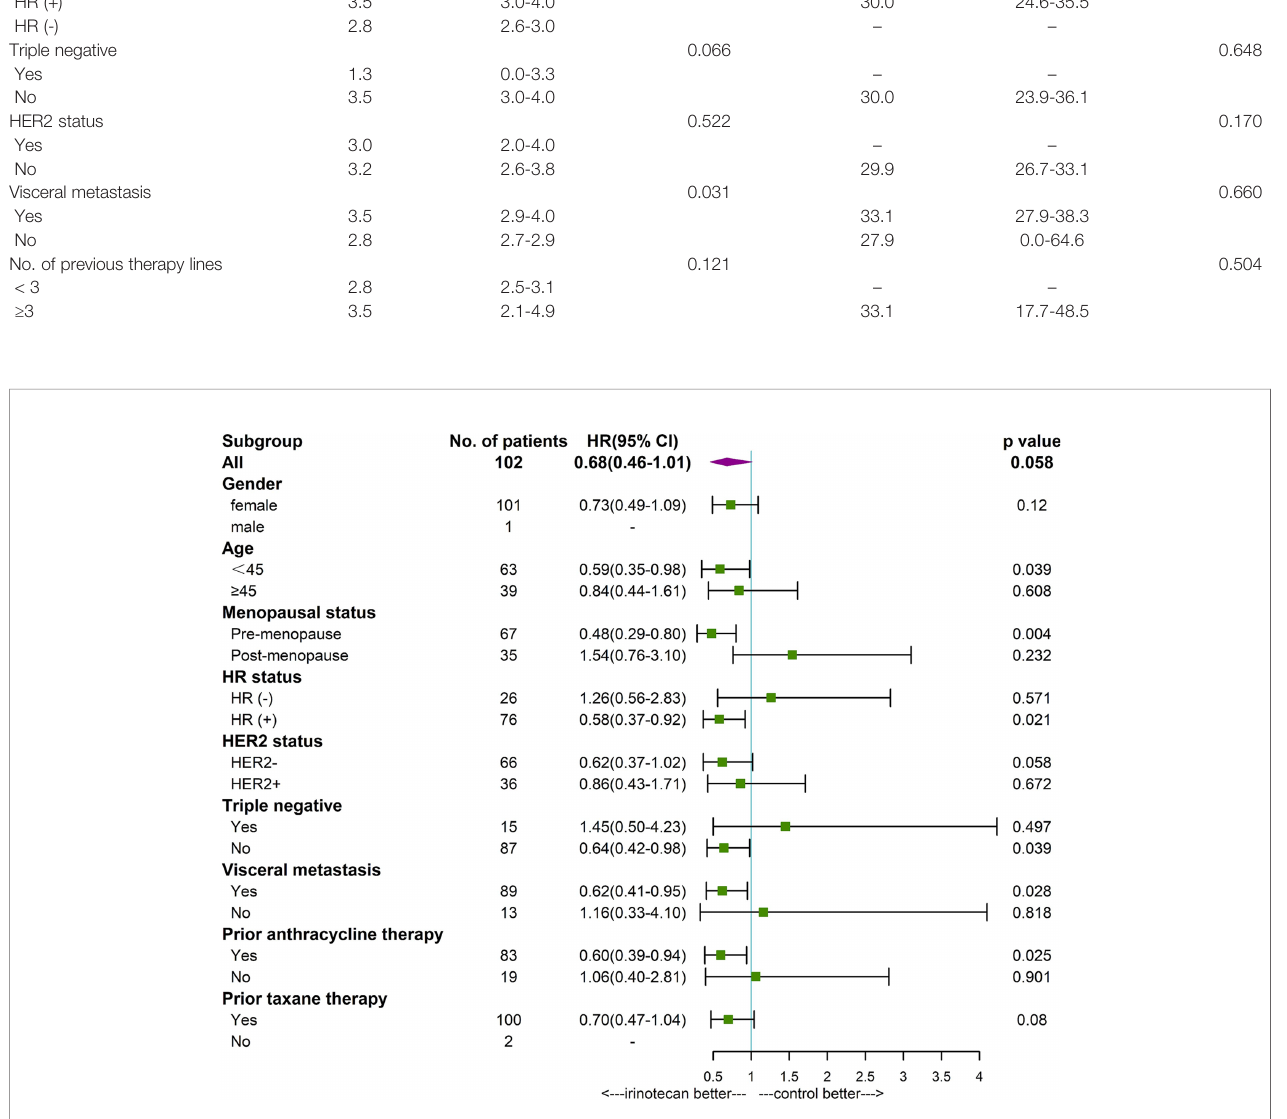
FIGURE 3 | Forest plot of PFS by